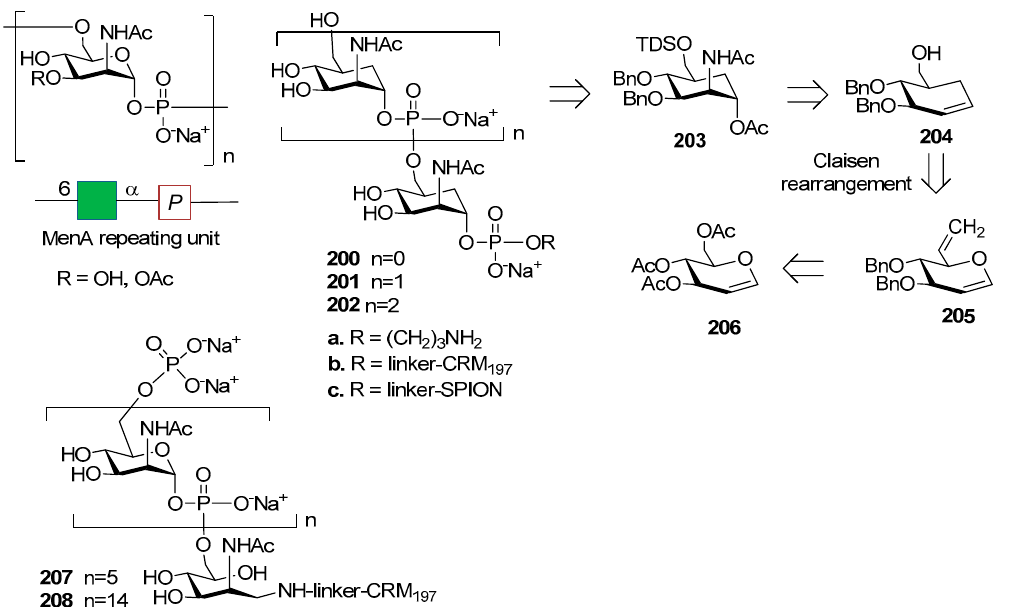
Figure 23. Men A CPS carbocyclic analogues reported in Reference [172].